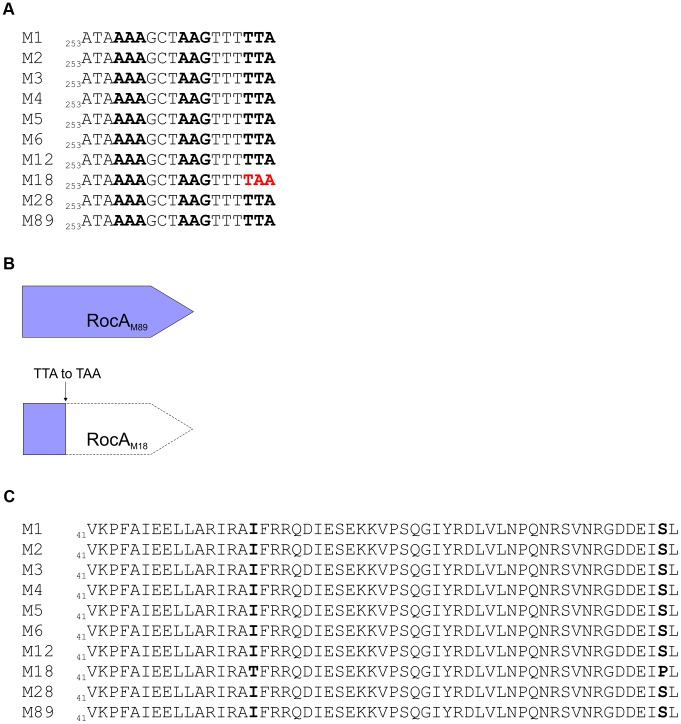
Identification of unique serotype M18 specific mutations in regulators RocA and CovR.RocA and CovR sequence comparison of isolates representing major GAS serotypes. Strains sequenced from each serotype are outlined in Table 1; at least one clinical isolate was tested for each serotype. Ten serotype M18 strains were sequenced including two obtained from patients in 1934. (A) rocA gene sequence of different M types. Codons are shown by alternating bold text. The premature stop codon in rocA
M18 is highlighted by red font. (B) The subsequent truncation in RocAM18 protein is demonstrated schematically in comparison with RocAM89. (C) CovR amino acid sequence in different M types. Highlighted residues indicate amino acid change in the M18 CovR protein resulting from non-synonymous mutations in the gene sequence compared with other M types. RocA and CovR sequences were also evaluated from genome sequenced isolates submitted to NCBI, representing serotypes M1, M2, M3, M4, M5, M6, M12, M18, M28 and M49.